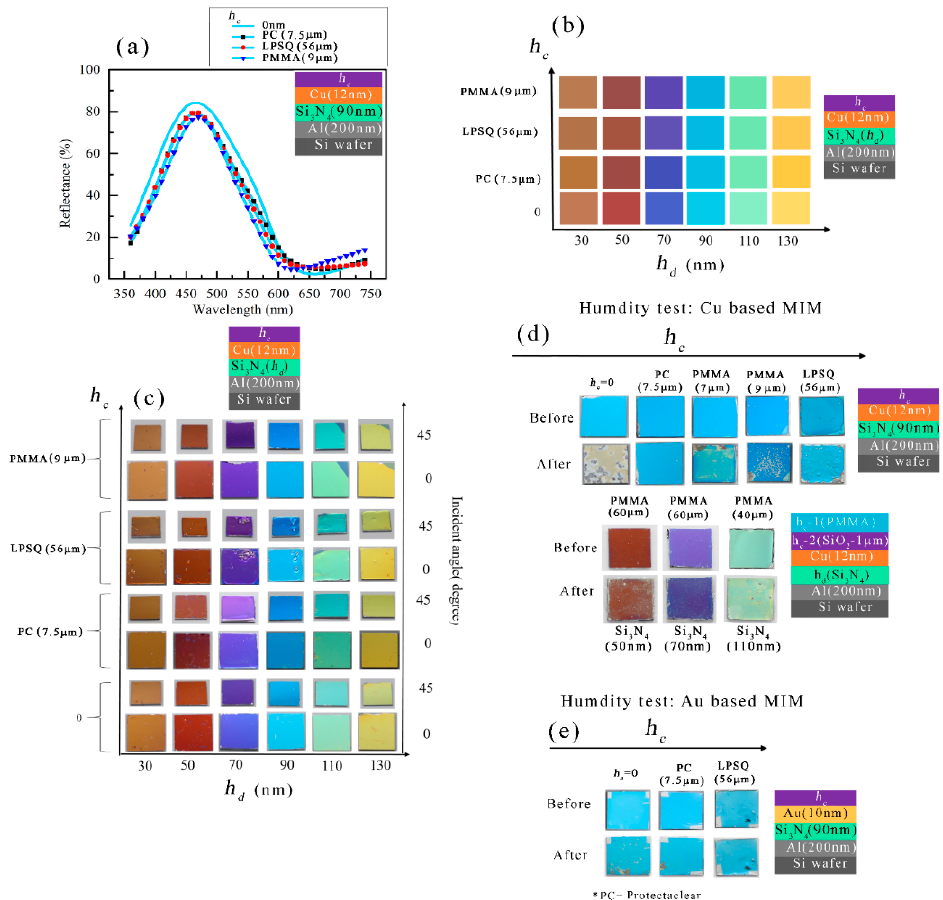
Figure 6. The reflectance spectra and structural colors of h c /Cu (12 nm)/Si 3 N 4 (90 nm)/Al (200 nm/Si structures where three different passivation layers were used as h c : Protectaclear coat (PC), LPSQ, and PMMA. ( a) The reflectance spectra of h c /Cu (12 nm)/Si 3 N 4 (90 nm)/Al (200 nm/Si MIM structures with three different passivation layers compared with uncoated structure. ( b )The measured colors of the h c /Cu (12 nm)/Si 3 N 4 ( h d )/Al (200 nm/Si MIM structures. ( c ) The color images were captured by a digital camera at 0 degrees and a 45-degree incident angle for the same structure of ( b ). The captured images of the before and after humidity test of the ( d ) h c /Cu (12 nm)/Si 3 N 4 (90 nm)/Al (200 nm)/Si and h c -1/ h c -2/Cu (12 nm)/Si 3 N 4 (90 nm)/Al (200 nm)/Si structures and of the ( e ) h c /Au (10 nm)/Si 3 N 4 (90 nm)/Al (200 nm/Si MIM structures.